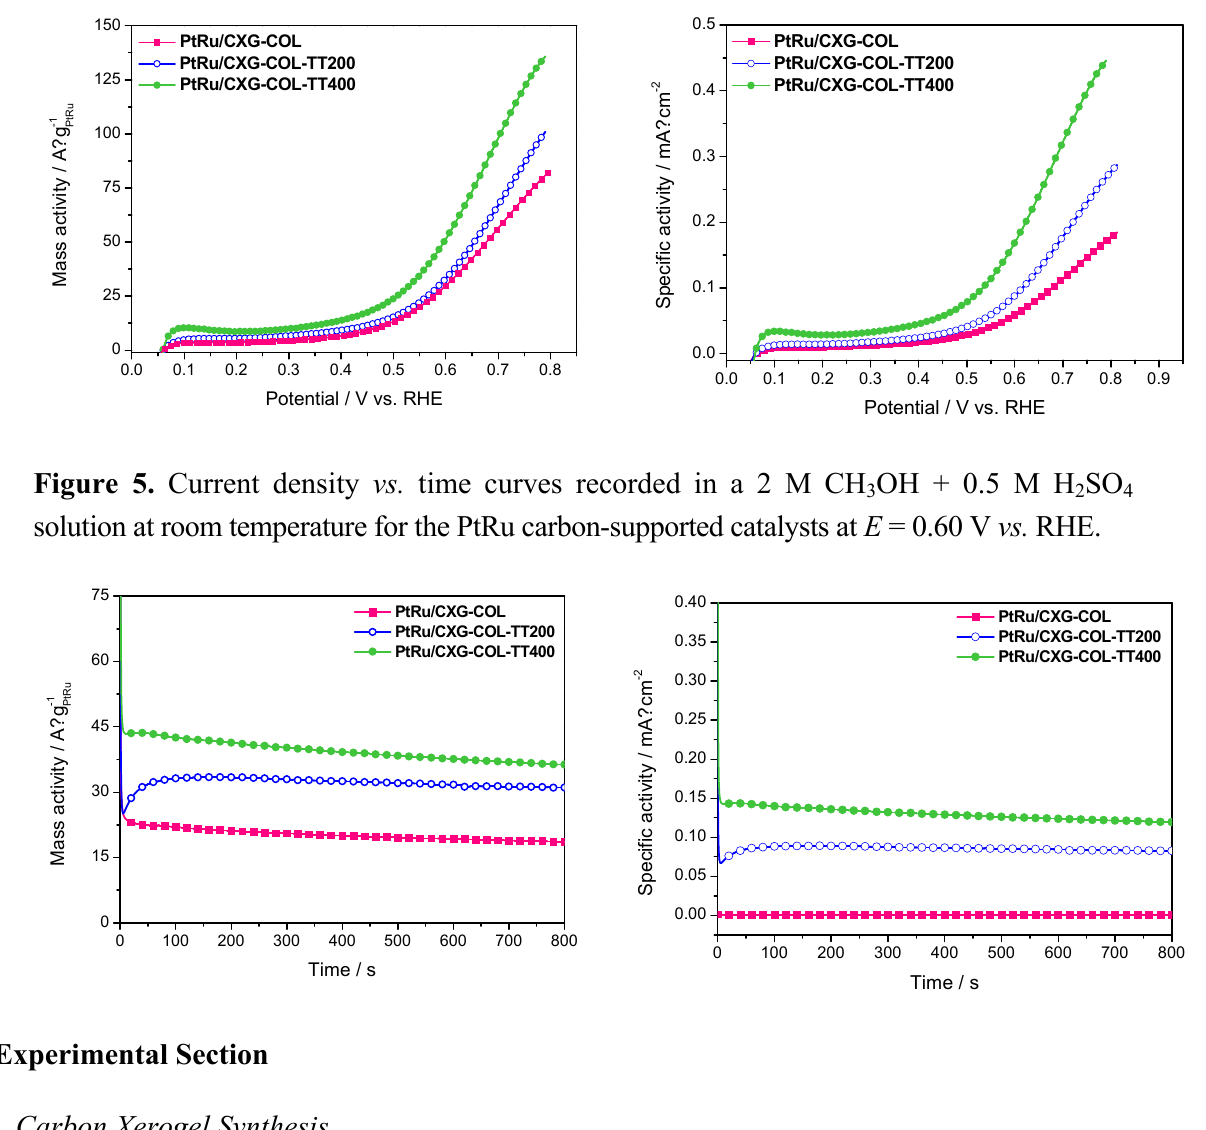
Figure 4. Polarization curves for the electro-oxidation of methanol in a 2 M CH SO solution at room temperature for the PtRu carbon-supported catalysts. Scan 0.5 M H 2 4 rate = 0.02 V s − 1 .